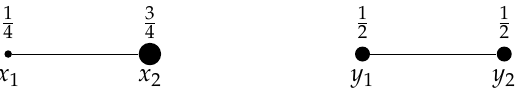
Figure 3. Two isometric but not isomorphic